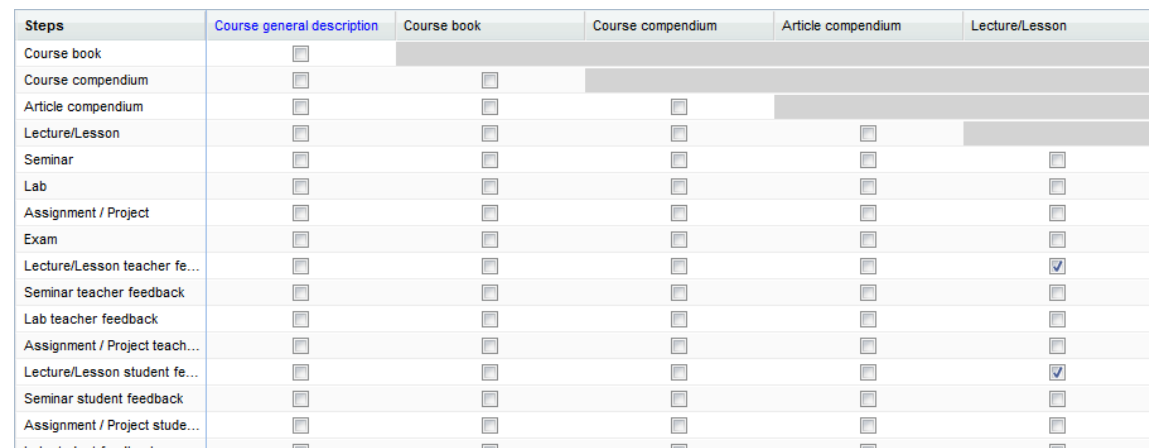
Figure A6. Step start rules